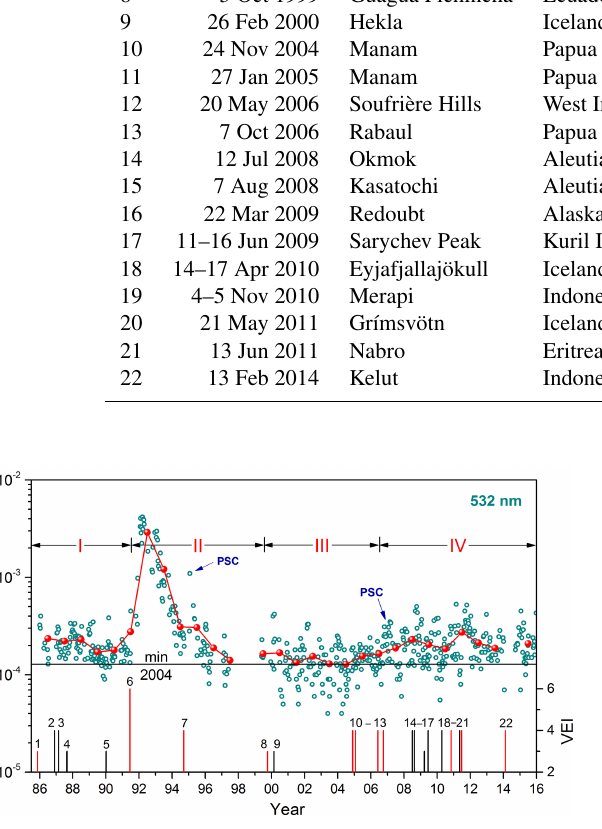
Figure 1. Shown are 30-year time series of the integrated strato- spheric backscatter coefficient at λ = 532nm over Tomsk between 15 and 30km. Open dark-green circles denote the 10-day average B a π values. Solid red circles show the annual average B a π values assigned to 1 July of each year. Black and red vertical bars at the bottom of the figure indicate volcanic eruptions (ranked on VEI) that caused the SAL volcanogenic perturbations over Tomsk from 1986 to the present day (see also Table 1). The red bars correspond to tropical volcanic eruptions, whereas the black ones correspond to eruptions of extratropical volcanoes located in the Northern Hemi- sphere. The thin horizontal line in Fig. 1 indicates the minimum value of the annual average B a π reached in 2004. PSC: polar strato- spheric